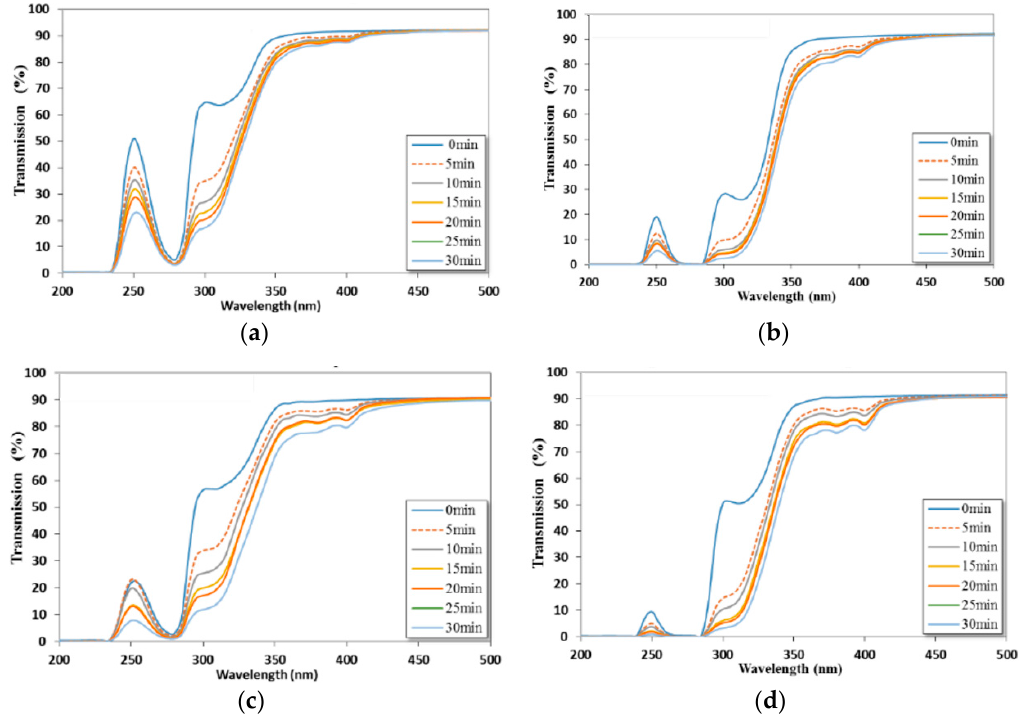
Figure 5. Optical transmissivity of ( a ) CBC-1, ( b ) CBC-2, ( c ) COC, and ( d ) COP thermoplastic substrates with UV/ozone treatment times from 0 to 30 min.